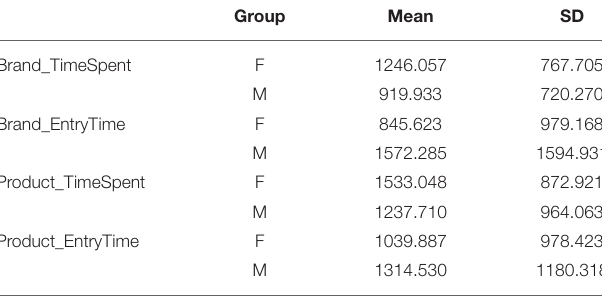
TABLE 4 | Descriptive statistics of Brand Time Spent, Brand Entry Time, Product Time Spent, and Product Entry Time in relation to